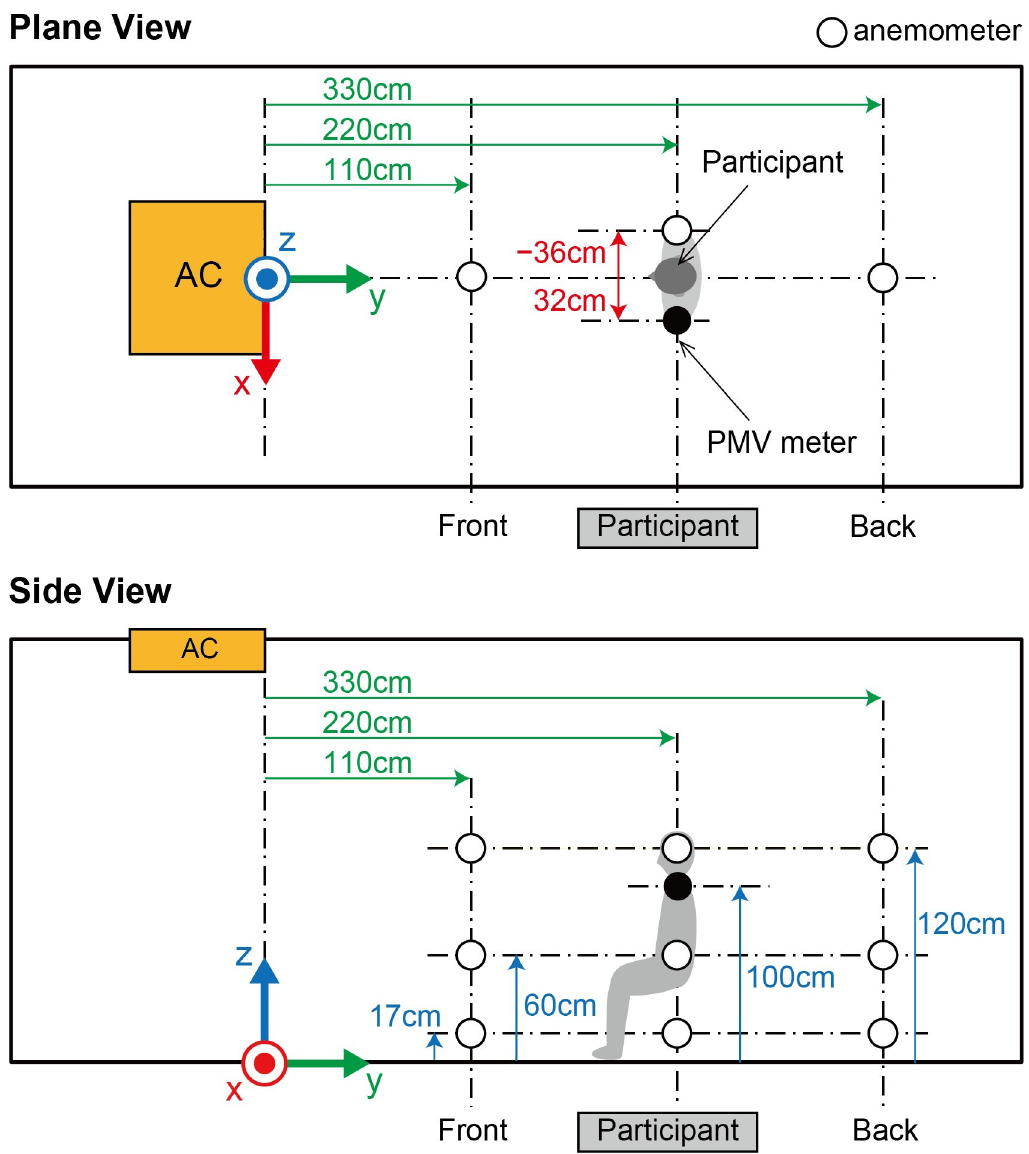
Fig 2. Measurement settings of wind velocity and direction. White circles indicate the nine locations where the wind velocity and direction were measured using an anemometer. The nine locations were combinations of the three points of the front-back direction and the three heights from the floor. Gray silhouette indicates the sitting position of a participant, and the black circle indicates the location of the PMV meter. AC indicates the location of the air conditioner.